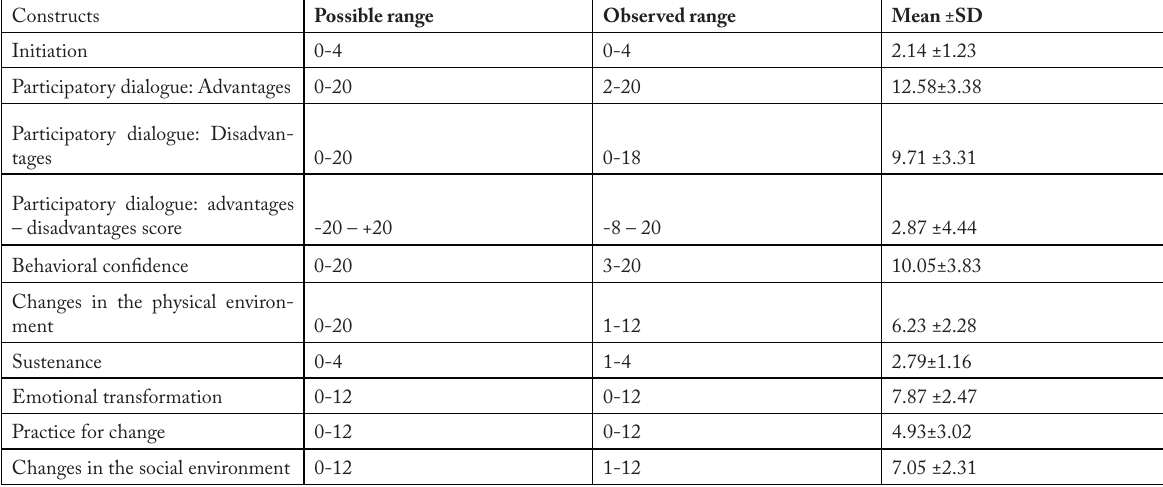
Table 2. Descriptive statistics of the constructs of MTM ( n = 214).